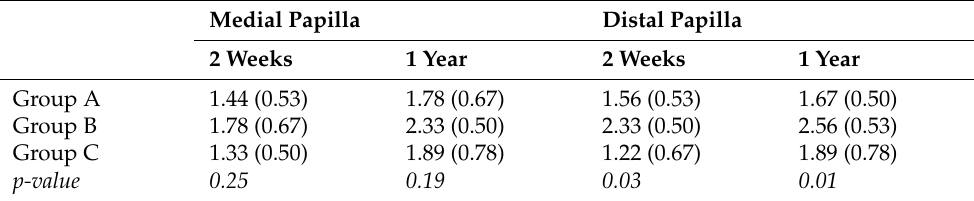
Table 9. Jempt’s papillae height analysis for each group. Medial Papilla Distal